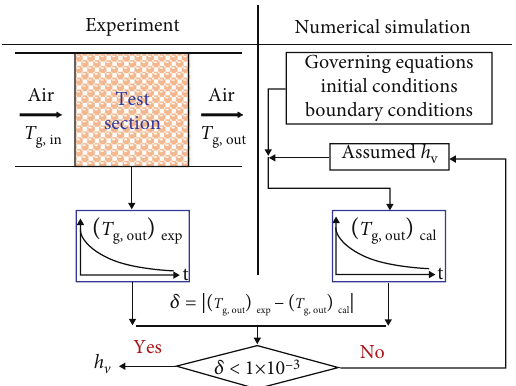
Figure 8: The whole process of calculating the heat transfer coe ffi cient by the inverse problem